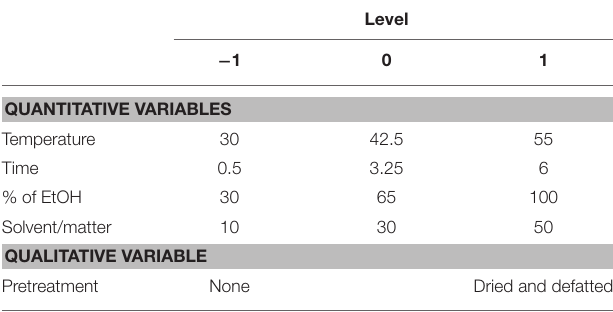
TABLE 3 | Independent variables and levels used for D-Optimal